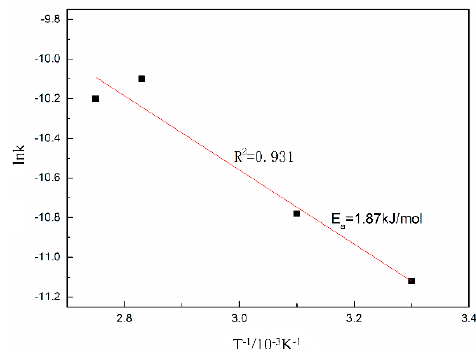
Figure 10. Arrhenius plot for iron leaching.